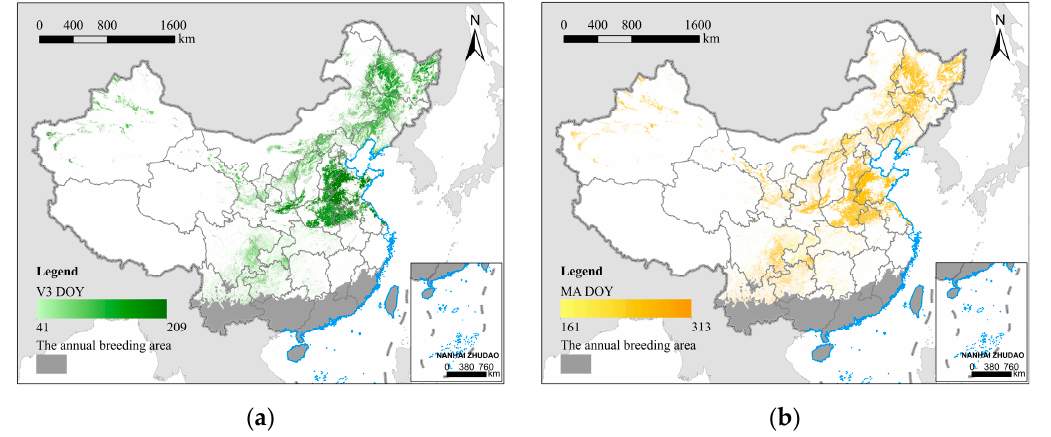
Figure 3. The mean DOY of the key phenological stages of maize, the main host plant for FAW in China from 2010 to 2019; ( a ) the 3rd leaf stage (V3); ( b ) the maturity stage (MA). The dark gray area represents the annual breeding area.